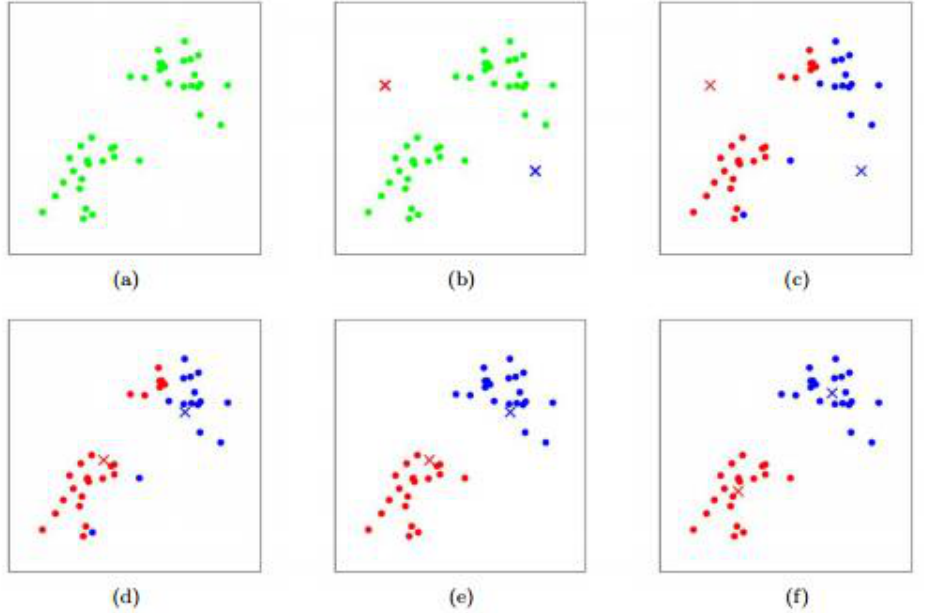
Figure 7. K-Means Iterations [83]. ( a ) Original dataset. ( b ) Random cluster initialization. ( c – f ) Successive iterations of K-means updating cluster centroids.